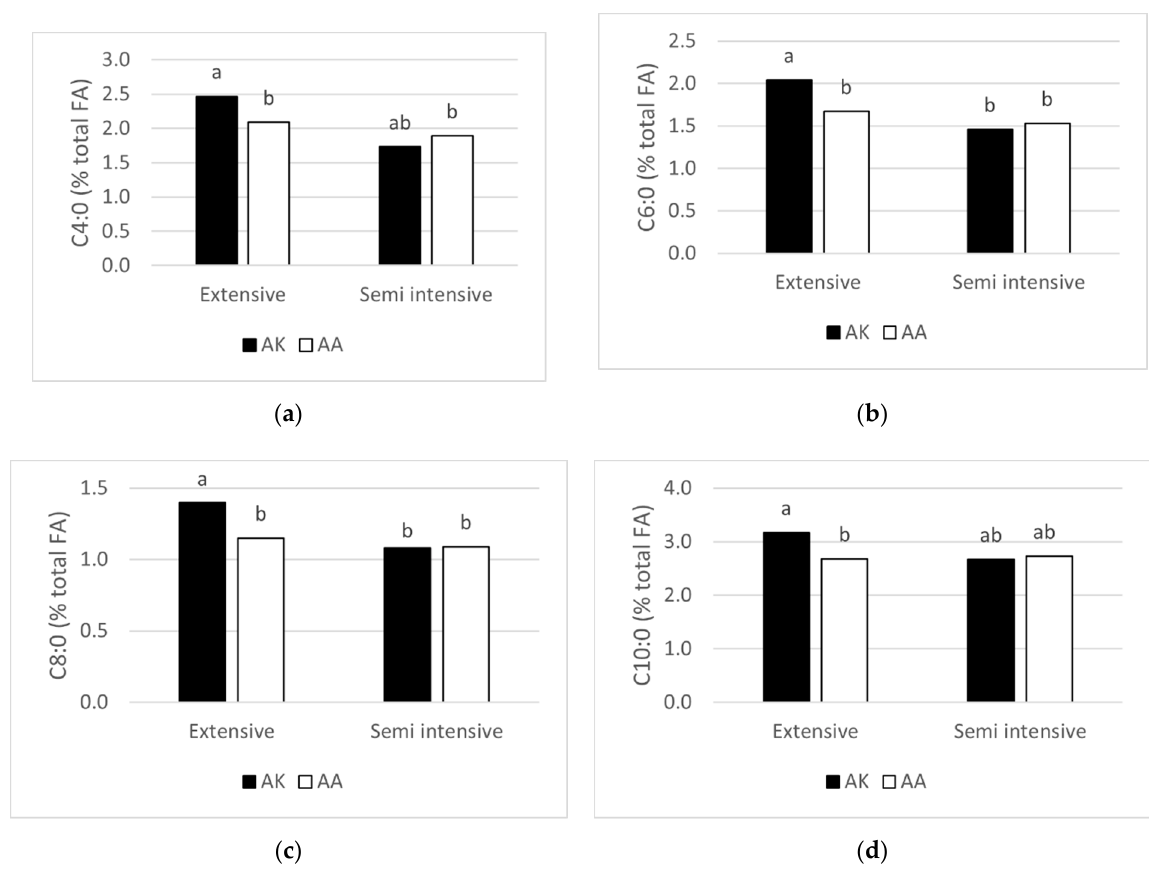
Figure 2. Effect of the interaction between genotype at DGAT1 K232A (AK and AA) and feeding system (extensive and semi-intensive) on C4:0 ( a ), C6:0 ( b ), C8:0 ( c ), and C10:0 ( d ) fatty acids. a,b Different superscript letters indicate differences ( p ≤ 0.05) between mean values tested by Tukey’s multiple comparison test.